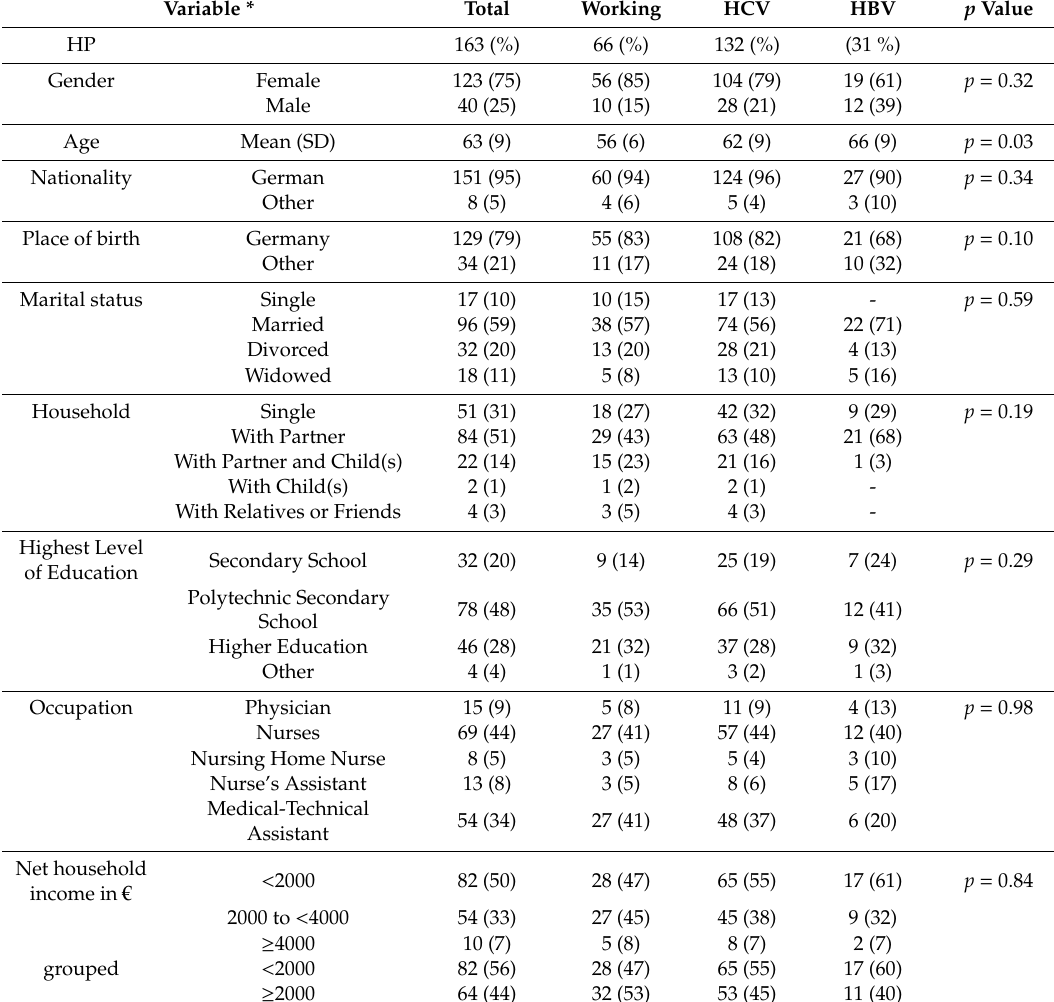
Table 1. Sociodemographic information (healthcare personnel n =